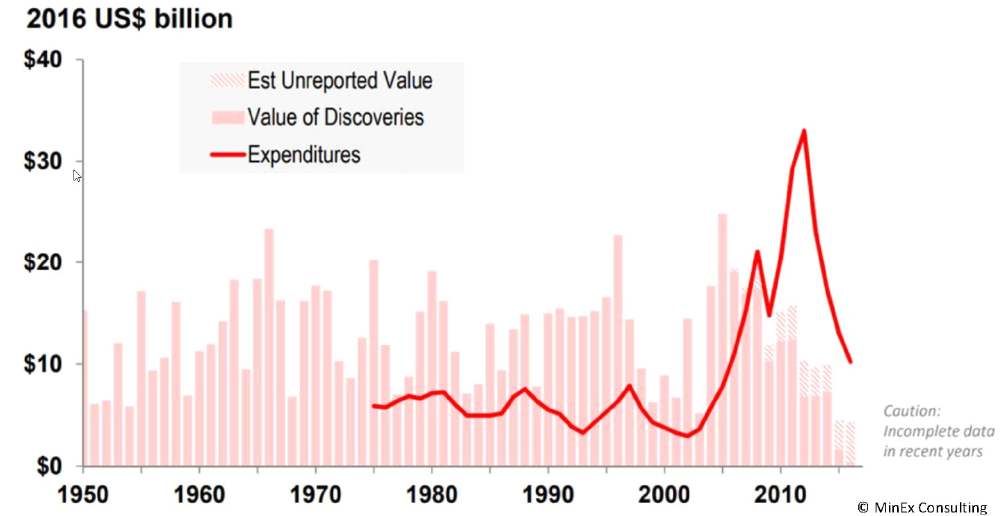
Figure 1. Declining rate of exploration success during last decade, despite increased exploration expenditure since mid- 2000’s. Adapted with permission from Schodde, R.C [1].